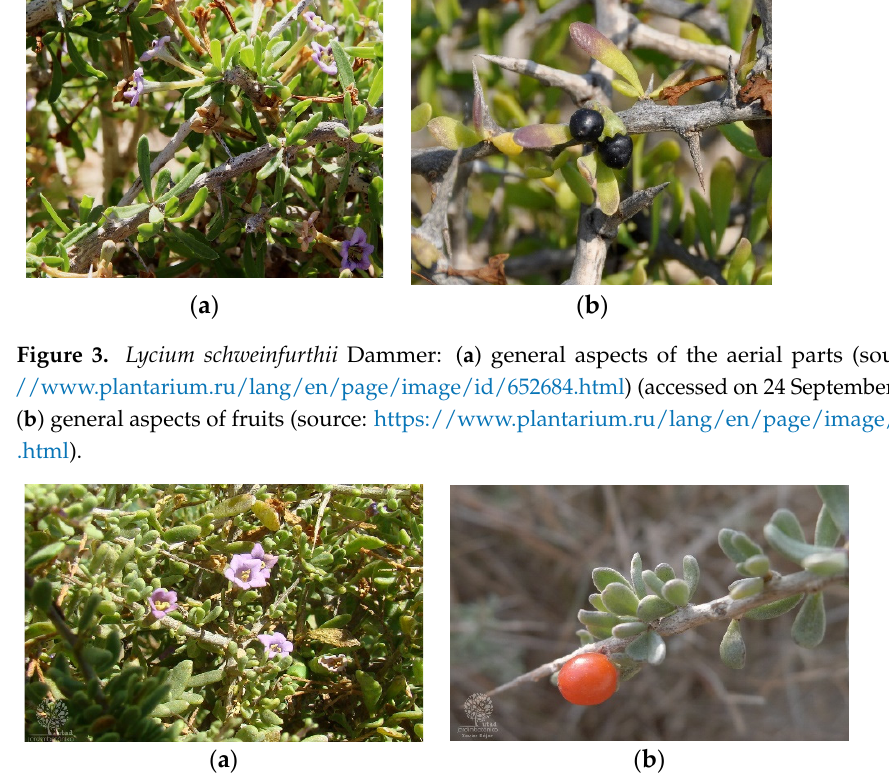
Figure 4. Lycium intricatum Boiss: ( a ) general aspects of the aerial parts (source: https://jb.utad.pt/multimedia/10921 (accessed on 24 September 2022); Imagem da espécie Lycium intricatum do Botânico UTAD, Flora Digital de Portugal.); and ( b ) general aspects of fruits and leaves (https://jb.utad.pt/multimedia/15805); Imagem da espécie Lycium intricatum por Xavier B é jar do Jardim Bot â nico UTAD, Flora Digital de Portugal.) https://www.plantarium.ru/lang/en/page/image/id/